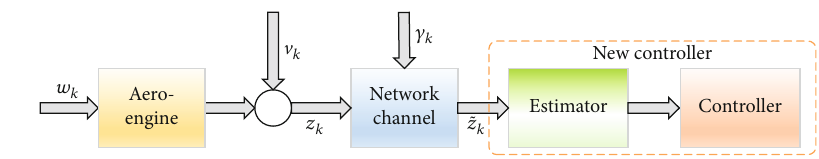
Figure 3: Network transmission with estimator.